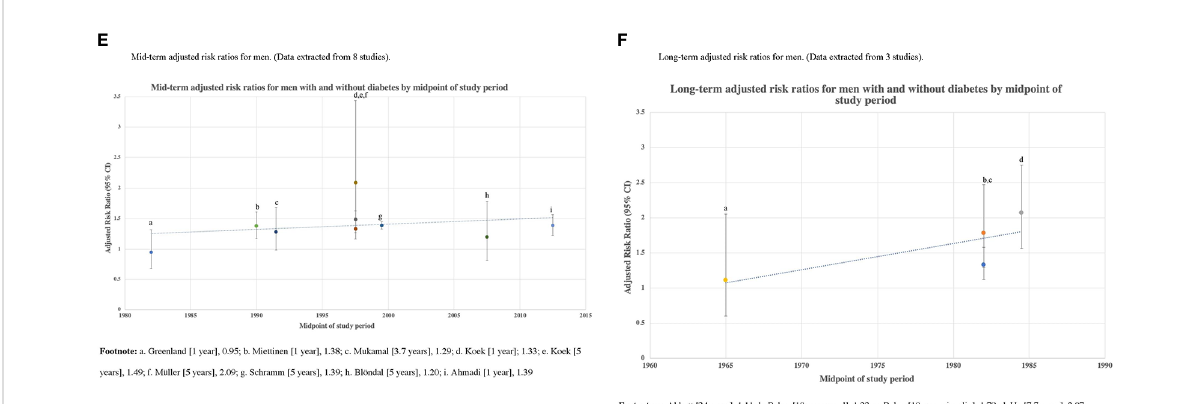
FIGURE 6 Time trends in adjusted short-, mid-, and long-term risk ratios for women and men with and without diabetes by the midpoint of study